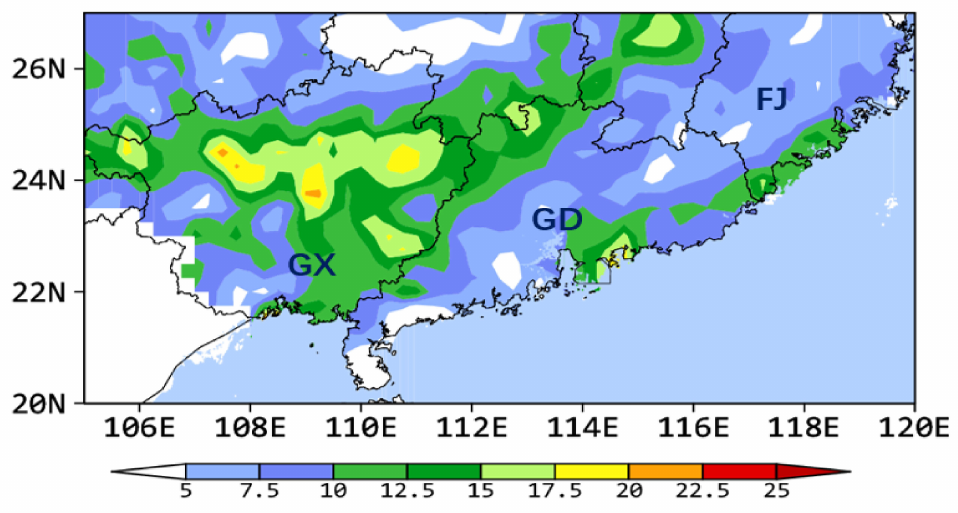
Figure 8. As in Figure 4, except for the 13 LLV-type WSHR events. As compared to the other two types of WSHR events, the predictability of the LLV-type events by NWP models appears to be superior due again to the conservative property of LLVs [54,57]. LLVs are typically of 300–400 km in diameter, and more evident below 700 hPa, even in the composite fields (Figure 9a). HR usually occurs in the eastern semicircle of LLVs, where is also the favorable region for isentropic uplifting from the potential vorticity viewpoint, given westerly vertical wind shears in the pre-storm environments. This can also be seen from Figure 9b, showing isentropic ascent of high- θ e air into the LLV region. When interacting with a warm-moist airstream in the PBL, deep convection can form successively at the southern to southeastern periphery of LLVs. The resulting latent heat release would in turn help enhance the intensity of LLVs. The three-dimensional extent of high- θ e air is greater than that associated with the PSF-type events (cf. Figures 5 and 9). In addition, the topographical lifting of the high- θ e air over Mt. Yunkai and Mt. Yunwu near the GD-GX border appears to be more pronounced in the LLV-type events than that in the other two types, due to their developments over different geographical locations. This can be seen from the sloping terrain shown in Figures 5b, 7b and